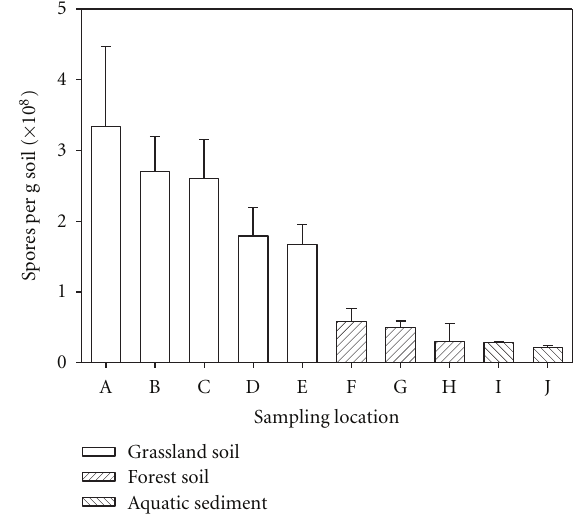
Figure 2: Spore content (expressed as equivalents of B. subtilis ) of soil from ten di ff erent locations. A: grassland soil (munici- pality of M¨annedorf, site 1); B: grassland soil (municipality of M¨annedorf, site 2); C: grassland soil (municipality of M¨annedorf, site 3); D: grassland soil (municipality of Uerikon); E: grassland soil (municipality of D¨ubendorf); F: forest soil (municipality of St¨afa, site 1); G: forest soil (municipality of St¨afa, site 2); H: forest soil (municipality of St¨afa, site 3); I: aquatic sediment (river Glatt in D¨ubendorf, site 1); J: aquatic sediment (river Glatt in D¨ubendorf, site 2). Bars represent mean values of triplicates. Carbon, hydrogen, and nitrogen content (in % of dry soil) was for grassland soil 6 . 9 ± 0 . 6, 0 . 98 ± 0 . 07, and 0 . 54 ± 0 . 03; for forest soil 4 . 7 ± 2 . 3, 0 . 84 ± 0 . 29, and 0 . 32 ± 0 . 12; for aquatic sediments 6 . 5 ± 0 . 4, 0 . 36 ± 0 . 09, and 0 . 11 ± 0 . 03, respectively.